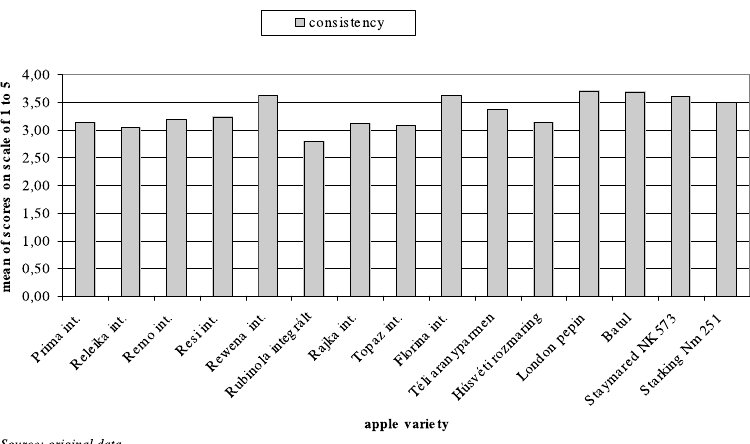
Figure 4: Mean scores given to the consistency of fruit flesh of apple varieties